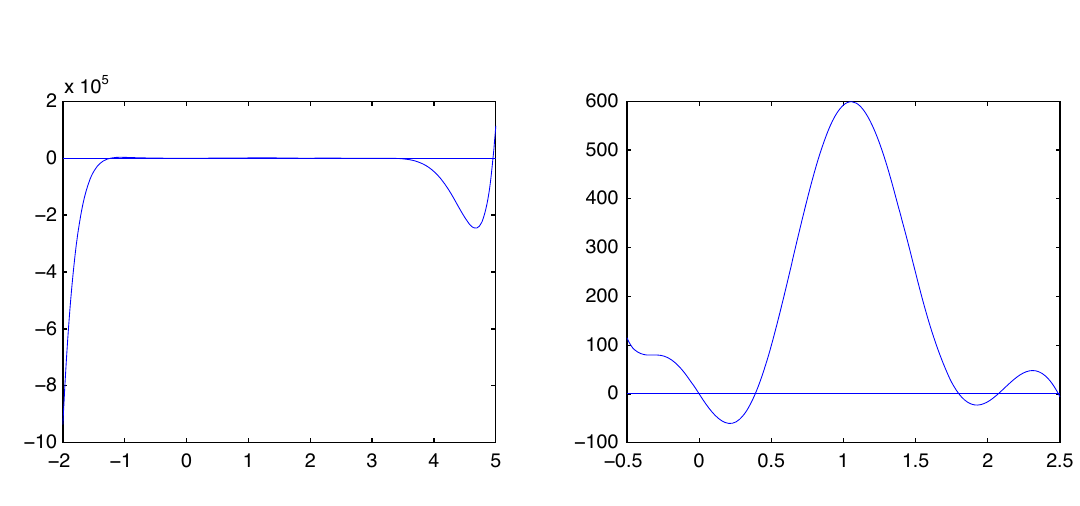
Figure 1: Characteristic function in Example